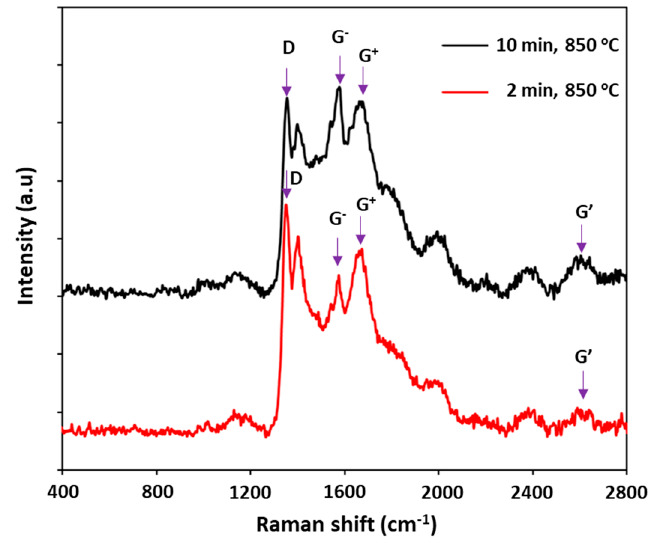
Figure 11. Raman spectra of the formed CNTs at different pretreatment times.